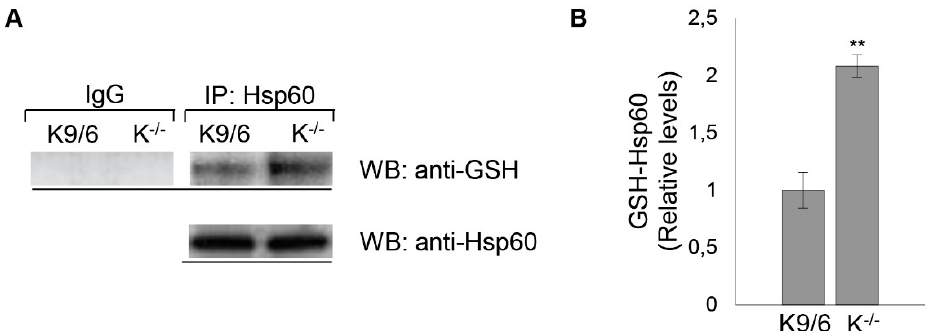
Figure 6. Confirmation of HSP60 S -glutathionylation induced by KRIT1 loss-of-function. ( A ) Lysates from K 9/6 and K − / − cells were immunoprecipitated with protein G agarose-coupled anti-HSP60 (IP: Hsp60) and subjected to Western blotting (WB) with anti-GSH antibody. Blots were then stripped and reprobed with anti-HSP60 antibody to ensure equal immunoprecipitation of HSP60 proteins. Mouse IgG was used as negative control for immunoprecipitation. ( B ) The histogram indicates mean ( ± S.E., n = 3) levels of GSH-Hsp60 relative to total Hsp60 in IP samples, as quantified by densitometric analysis of WB bands. Normalized optical density values were expressed as relative protein level units. Asterisks indicate significant differences versus K 9/6 cells ( p ≤ 0.01).